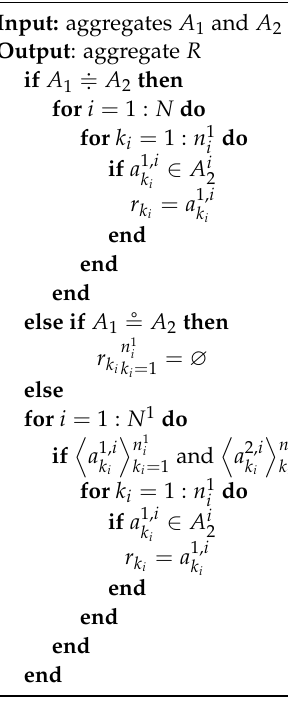
( a ) The given compatible aggregates.